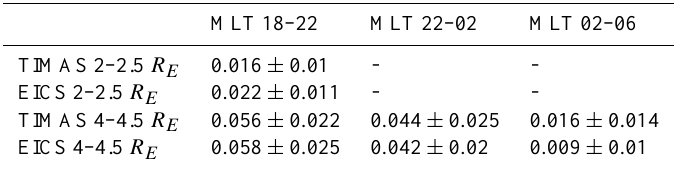
Fig. 1. Polar/TIMAS (left), DE-1/EICS (right). Top: All detected 0.5–10keV beams as a function of radial distance R ( R E ) and beam peak energy. Middle: Hours spent by the instrument in each bin. Bottom: Occurrence frequency of ion beams (number of points in each bin divided by the number of 12-s samples coming from the bin, averaged over ILAT). Small K p ( ≤ 2) shown by filled circles, large K p ( > 2) by triangles. Dotted line is both K p s put together. All nightside MLT sectors (18–06) are included and the satellite footpoint is Sun-illuminated. The method of calculating the error bars is explained in the text. The ILAT range is 65–74. Table 1. TIMAS and EICS high K p ion beam occurrence frequency when footpoint is